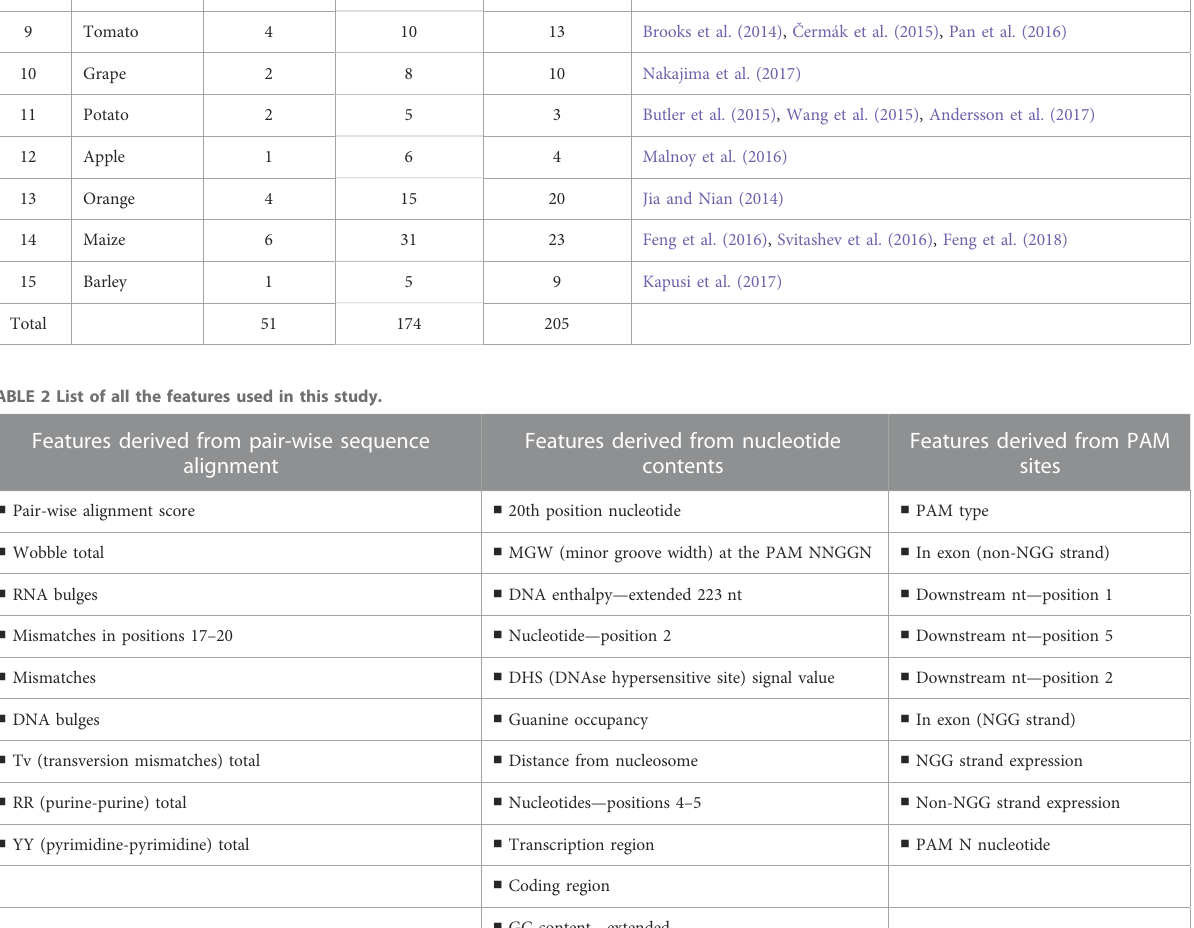
Features derived from PAM